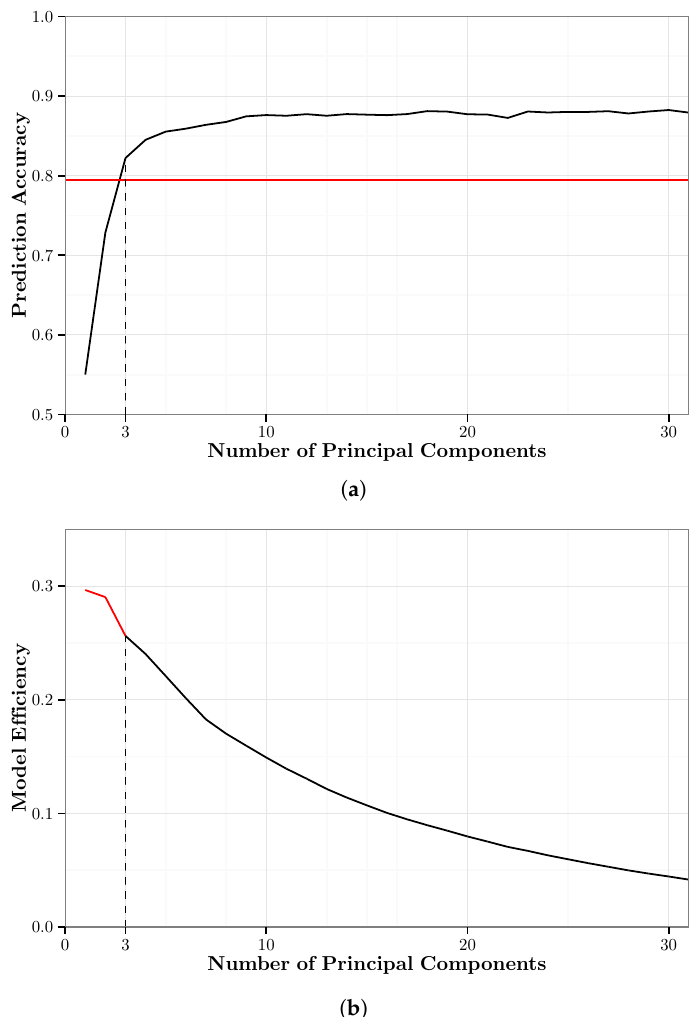
Figure 7. A graphical summary of the PCA-RF models. ( a ) Ten-fold cross-validation accuracy of the PCA-RF models. The solid black line represents the prediction accuracy; the solid red line represents the minimum cut-off accuracy for the optimal model; and the dashed black line represents the minimum number of principal components necessary to attain the cut-off accuracy. ( b ) Model efficiency metric of the PCA-RF models. The red portion represents models that do not meet the cut-off accuracy; the black portion represents models that do meet the cut-off